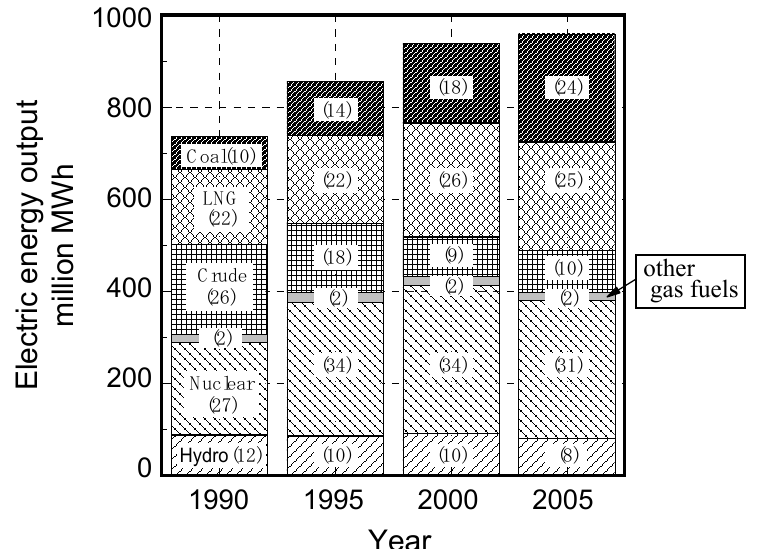
Figure 4. Transition of composition ratio for electric power generation in